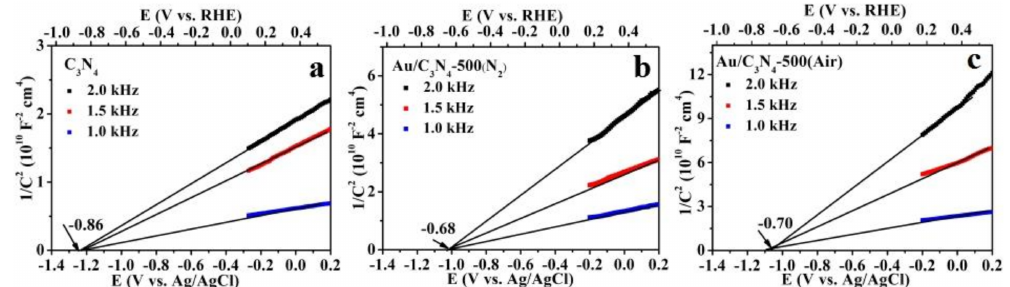
Figure 9. Mott–Schottky plots of ( a ) C 3 N 4 , ( b ) Au/C 3 N 4 -500(N 2 ), and ( c ) Au/C 3 N 4 -500(Air) in an acidic solution (pH 3) in the dark. The frequency used was 1.0 kHz, 1.5 kHz, and 2.0